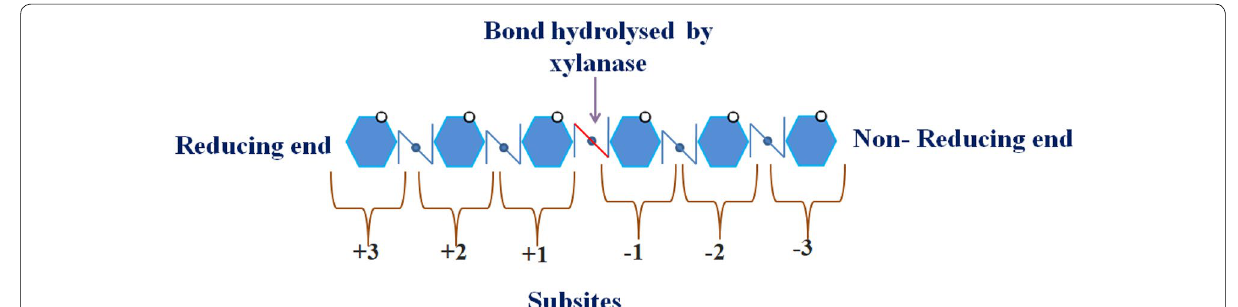
Fig. 4 Schematic representation of site for attack of GH10 xylanase on